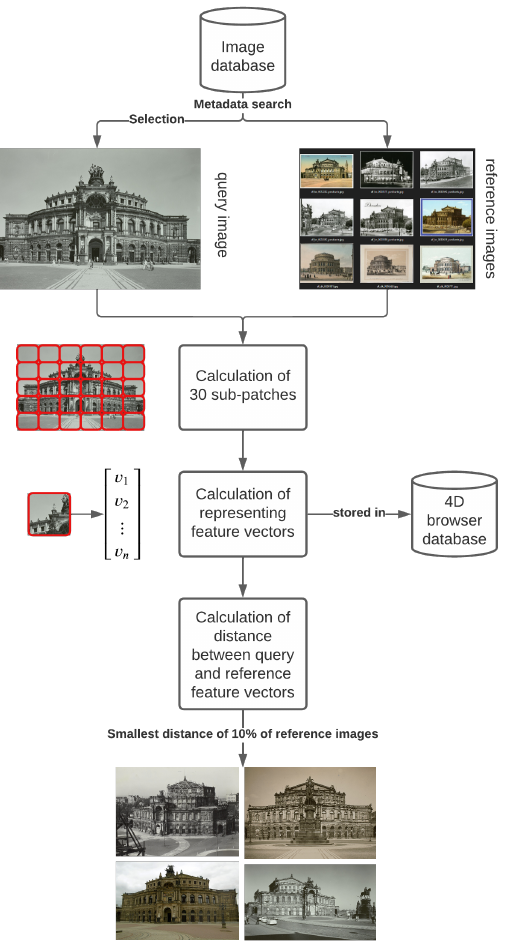
Figure 4. General overview of the workflow in the layer extraction approach